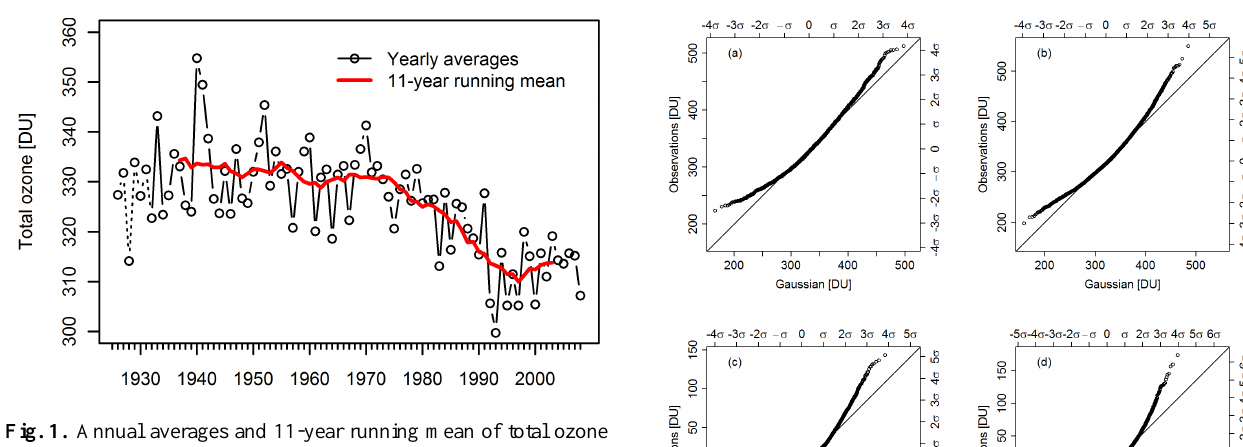
Fig. 1. Annual averages and 11-year running mean of total ozone over Arosa, Switzerland 1927–2008. Note: dotted line for annual averages marks period with large fractions of missing data before 1932.